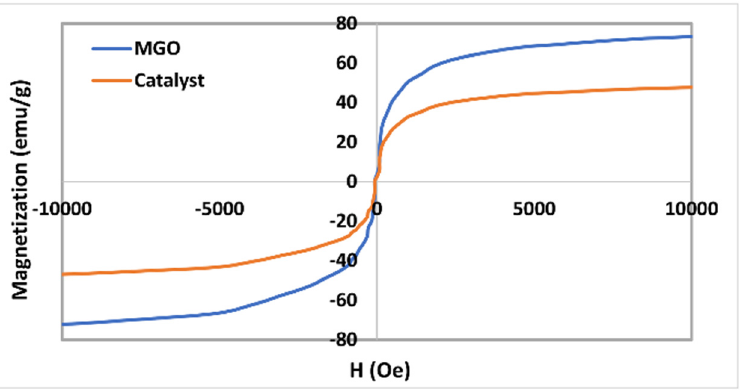
Figure 5. VSM curve of SPION and SPION@CS −− IL.